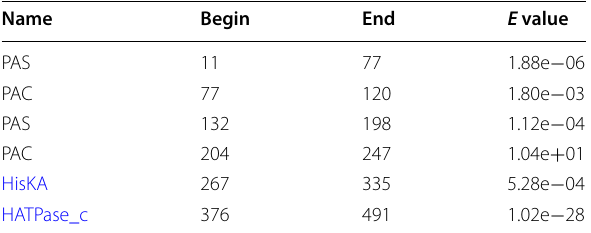
Table 4 Predicted domains, repeats, motifs and features, generated using